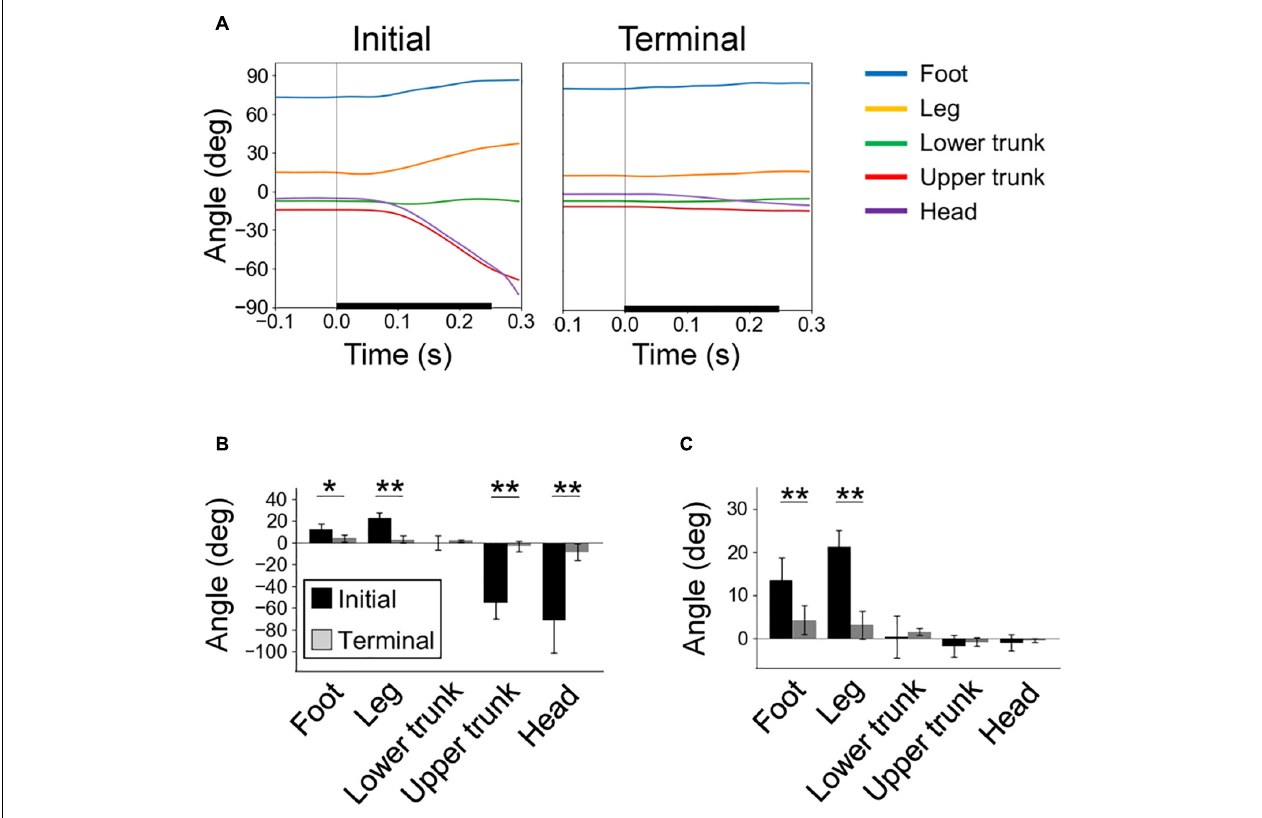
FIGURE 4 | Rotation of body segments due to perturbation. (A) Time series of segment angles in the initial (left) and terminal (right) trials, with the start time of floor tilting at time 0. Definitions of segment angles are in Figure 1E . (B) Rotation angles of segments from the start of floor tilt to 0.3 s later. (C) Effects of segment rotations on the CoM angle calculated by Eq. (1). In (A–C) , individual averages ( n = 6) of trial averages (initial and terminal eight) are shown. * P < 0.05; ** P <